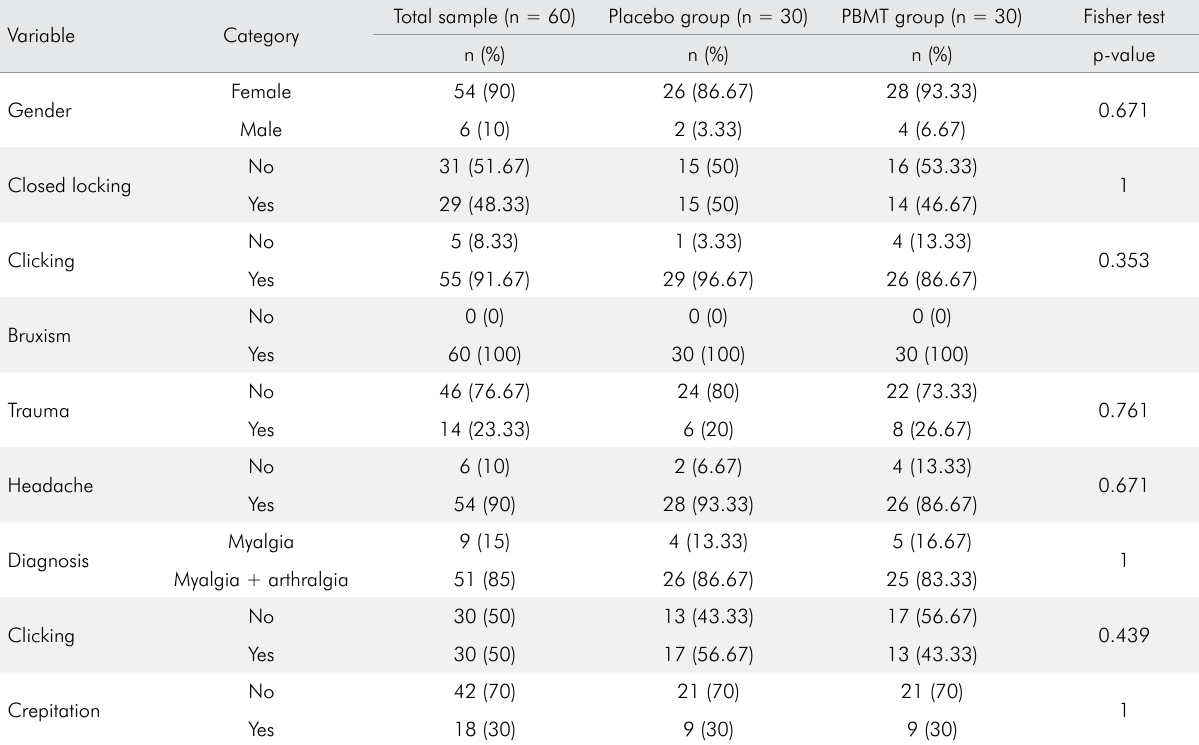
Table 1. Description of the qualitative variables of the total sample, placebo and PBMT groups.